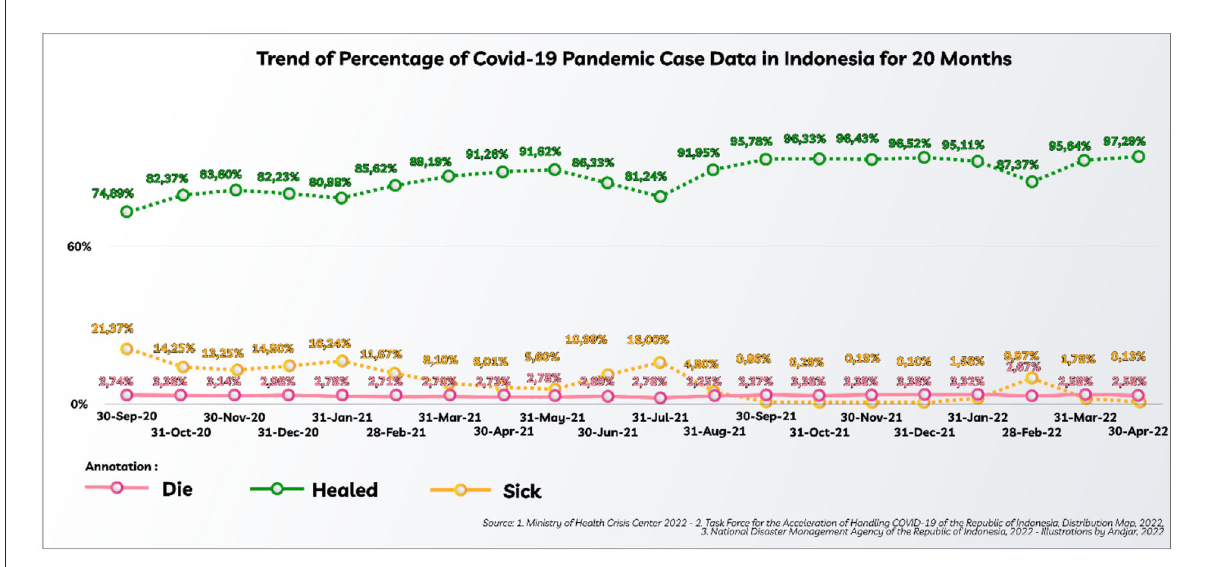
FIGURE1 The trend of percentage of COVID-19 pandemic case data in Indonesia for 20 months.